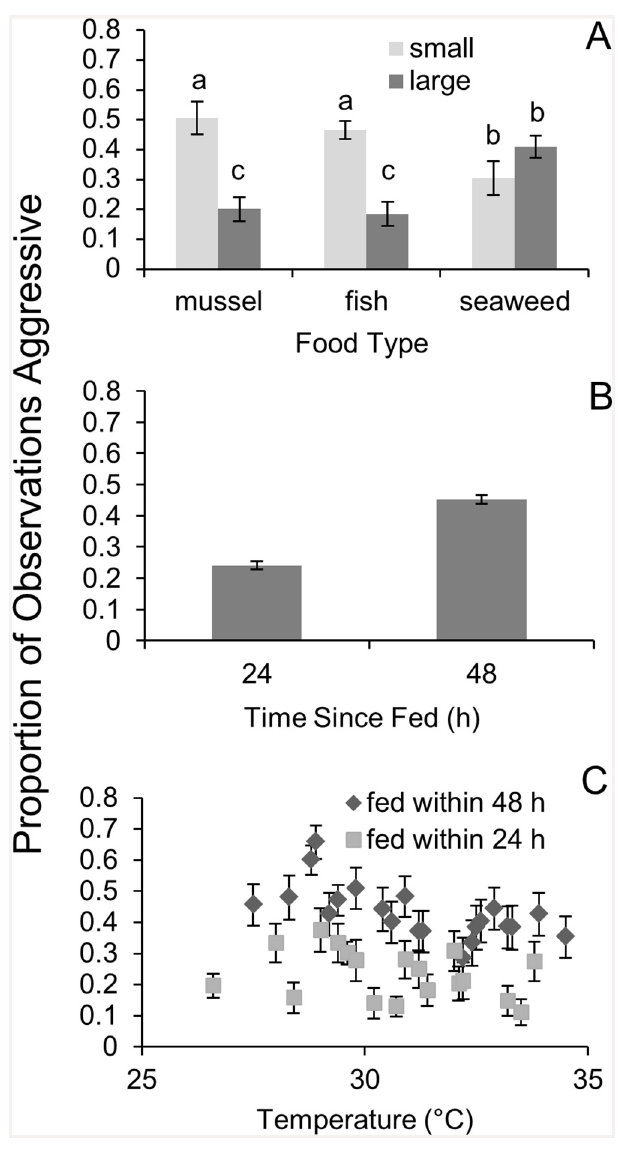
Fig 1. Analysis of crab behavior. Mean ± SE aggression probability of crabs as a function of A) diet (n = 10), B) time since last feeding (24 or 48 h; n = 1168 and 1163 respectively), and C) daily temperature (°C) within holding containers for crabs fed within 24 or 48 h (n = 53 – 159). Replicates depend on the number of surviving crabs and times exposed to the same temperature (max = 3 same